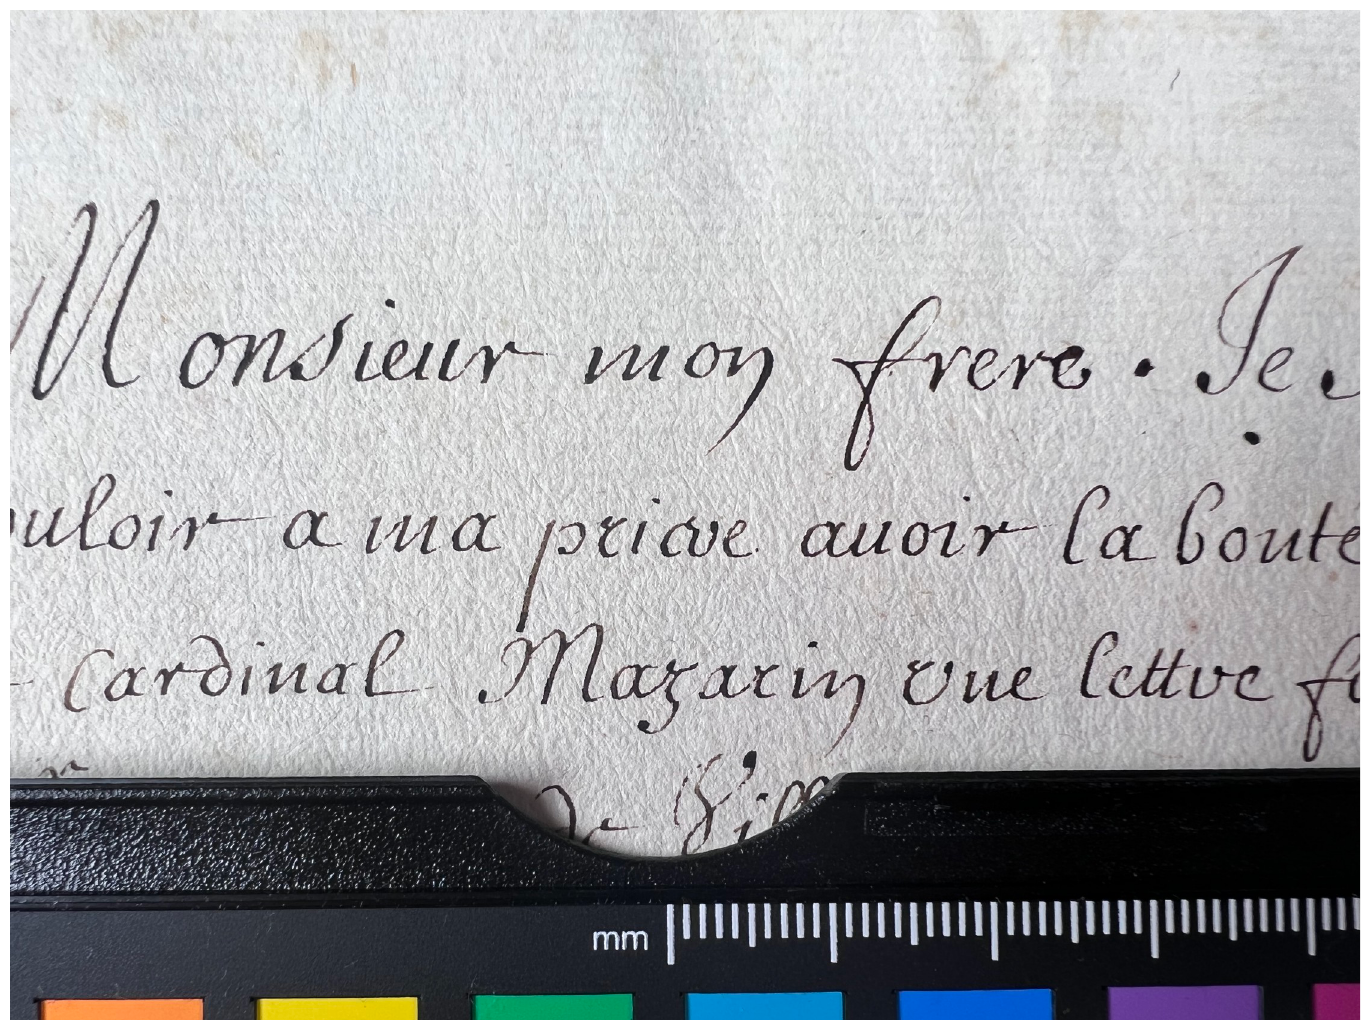
Fig 13. Ink thickness 2. Visual estimation of ink thickness 2, exemplified through a document from volume K 400 of the Azzolino collection.